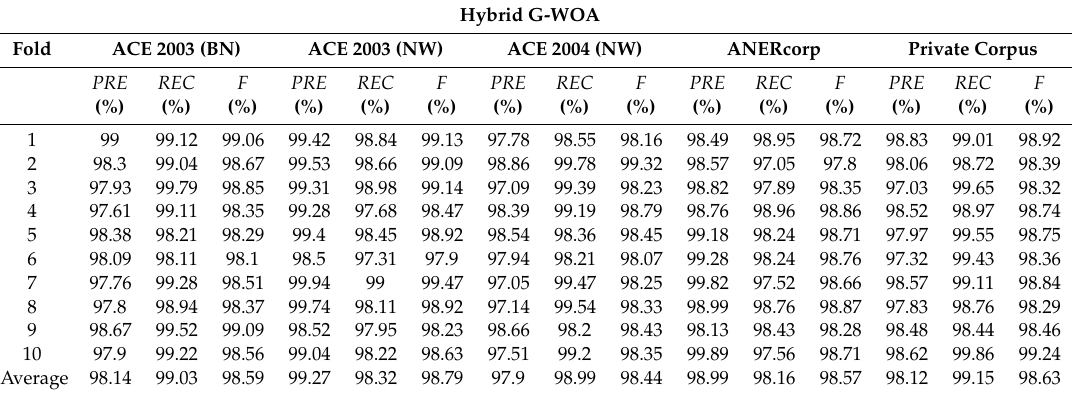
Table A1. Performance evaluation of ontology learning using the proposed G-WOA over the five